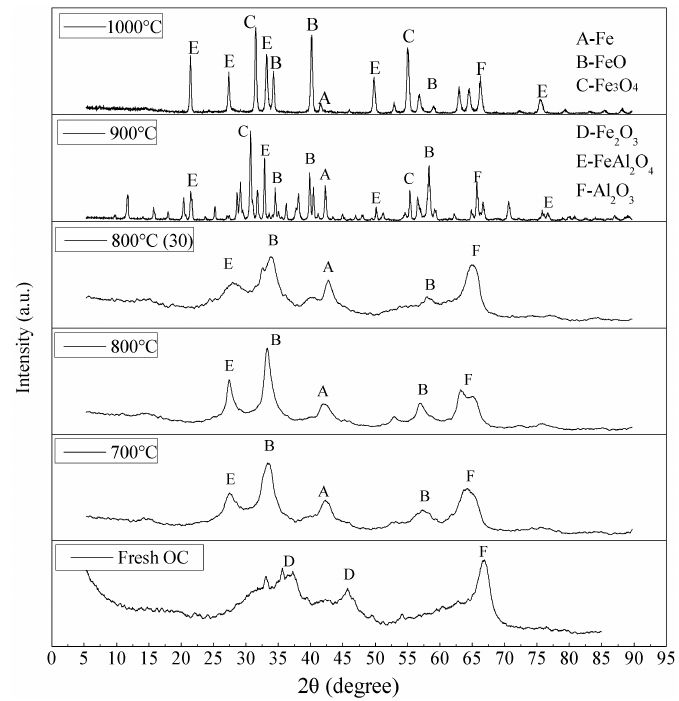
Figure 10. XRD patterns for the fresh Fe 2 O 3 /Al 2 O 3 and the used Fe 2 O 3 /Al 2 O 3 after five redox reaction cycles under various temperatures. cycles under various